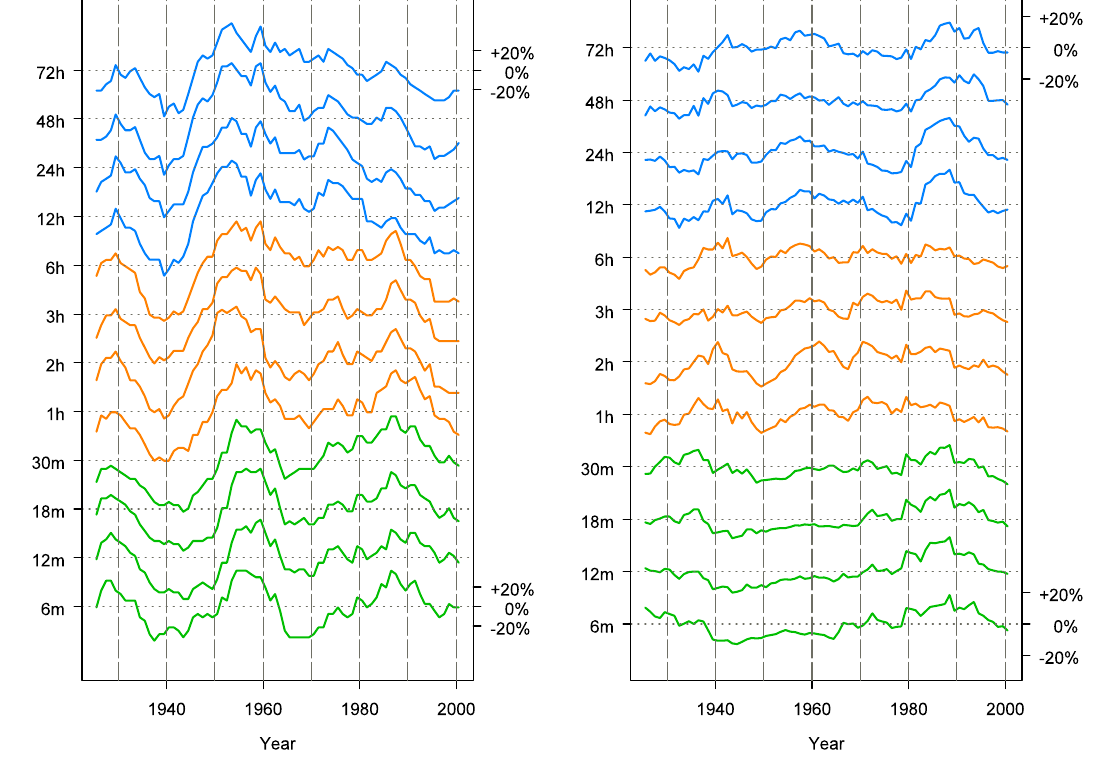
Fig. 1. Percentage difference in frequency (left panel) and magnitude (right panel) for 10-yr sliding windows against the long-term average for POT3. Green, yellow, and blue lines indicate “short”, “intermediate”, and “long” durations, respectively.